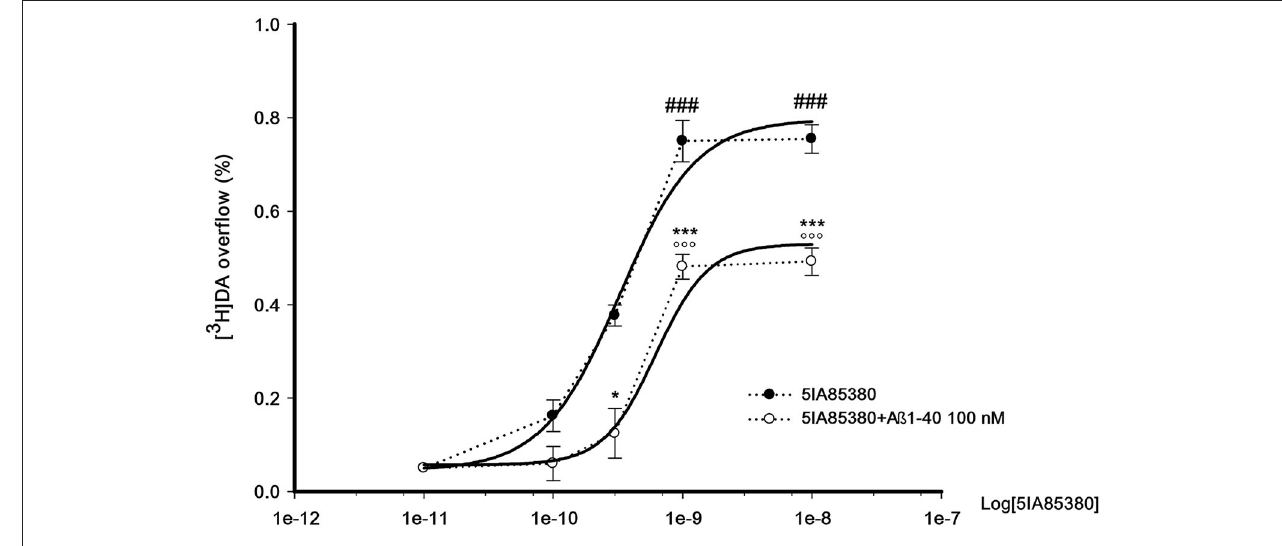
FIGURE 3 | Concentration-dependent effect of 5IA85380, alone or in presence of A β 1-40, on [ 3 H]DA overflow from rat NAc synaptosomes. Data are means ± SEM of at least four experiments run in triplicate, ### P < 0.001 versus 5IA85380 (100 pM), ◦◦◦ P <